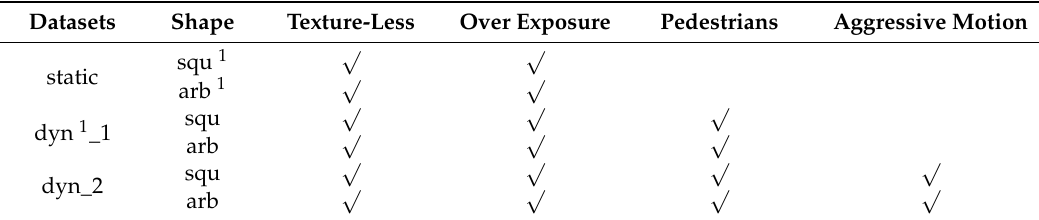
Figure 12. The experimental and datasets environment. ( a ) Indoor environment; ( b ) the normal condition in datasets; ( c ) the texture-less area and over exposure condition; ( d ) the pedestrians and aggressive motion. Table 1. Home-made datasets and the respective included items.